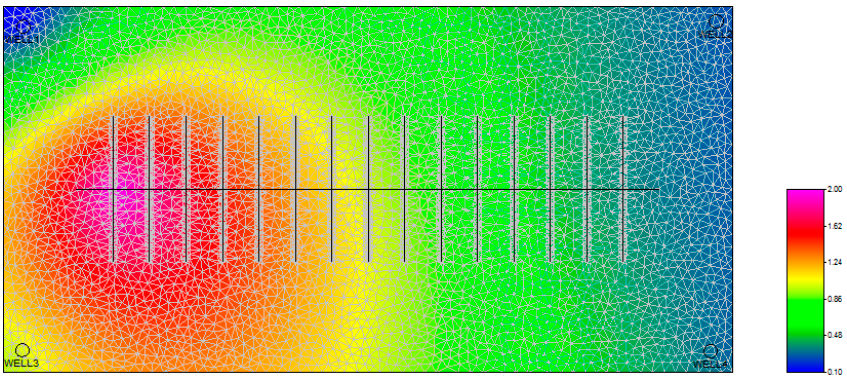
Figure 17. Delaunay triangulation of the heterogeneous waterflood model.